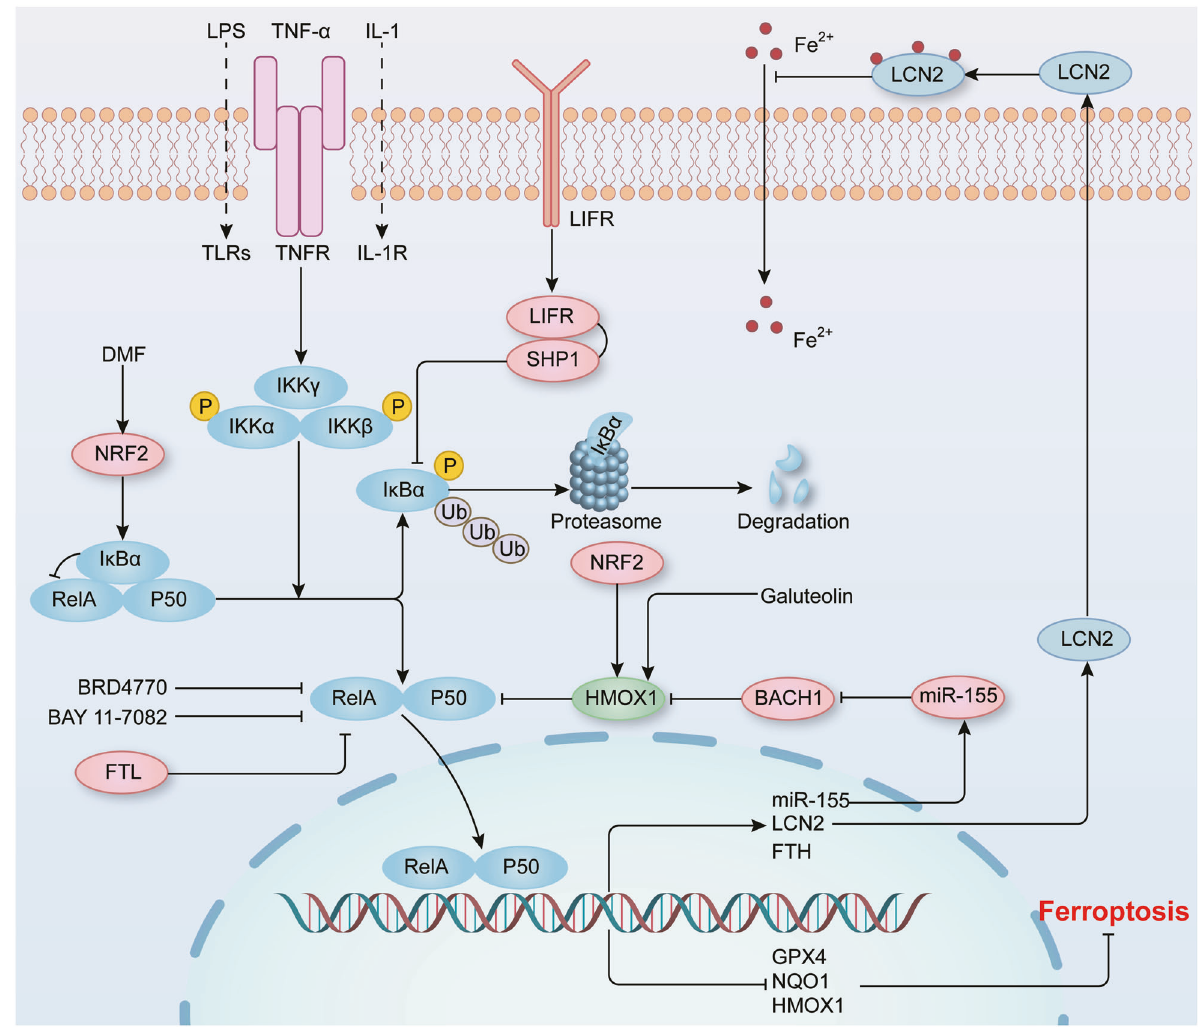
Fig. 4 The role of NF- κ B signaling pathway in ferroptosis. The classical signaling pathway is activated by Toll ‑ like receptor ligands (such as LPS), TNF, IL-1, and other stimuli. Under resting conditions, I κ B α combines with NF- κ B dimers to sequester NF- κ B activity. These signaling molecules combine with their corresponding receptors and mediate the phosphorylation and subsequent degradation of I κ B α . Then, the liberated NF- κ B dimers are translocated to the nucleus and regulate target gene transcription. On the one hand, NF- κ B can reduce the transcription of antioxidant molecules, such as GPX4, NQO1, and HMOX1, indicating the contribution of the NF- κ B pathway to oxidative stress. On the other hand, the loss of LIFR enhances I κ B α ubiquitination degradation and positively regulates NF- κ B activation, which further promotes LCN2 secretion to sequester extracellular iron. In addition, a few agents, including BRD4770 and BAY 11-7082, exert their anti- ferroptosis effects via inhibiting NF- κ B